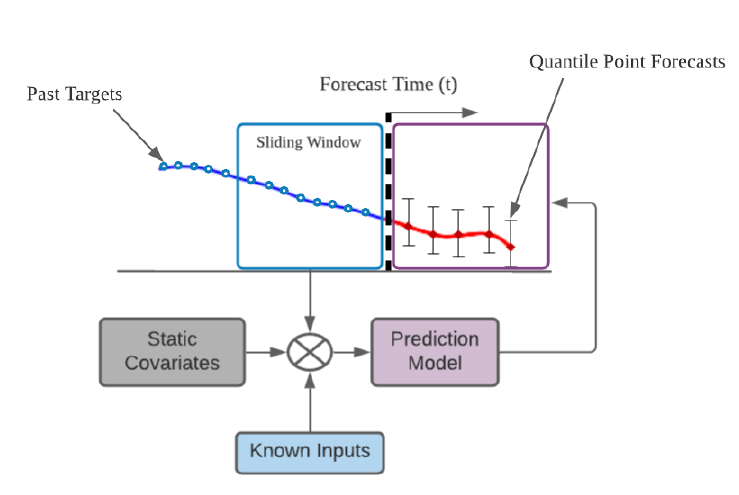
Figure 11. Sketch of static covariate multi-horizon forecasting and past-observed